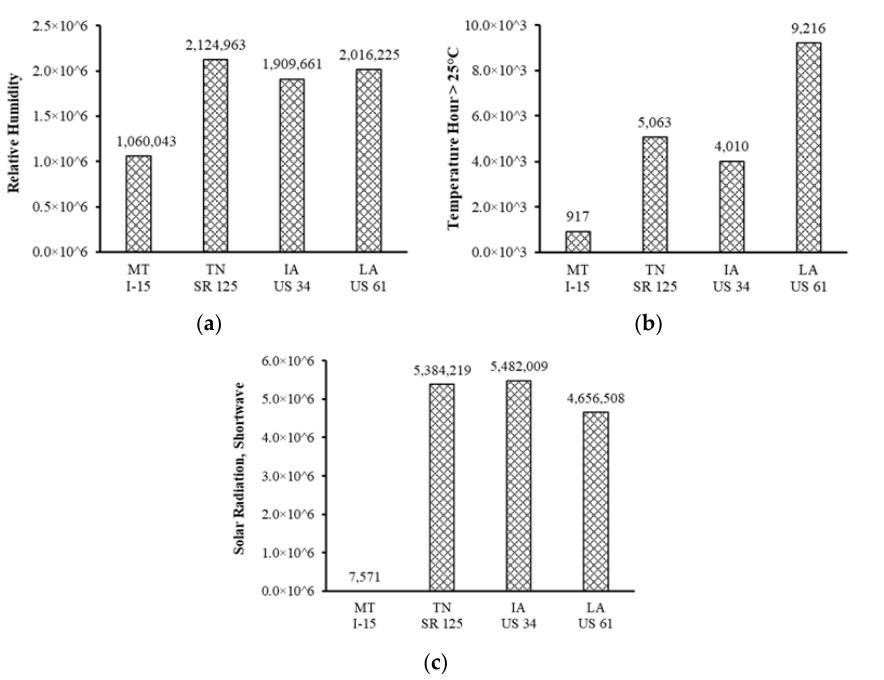
Figure 2. Field climate information: ( a ) relative humidity; ( b ) air temperature hour > 25 °C; ( c ) shortwave solar radiation.